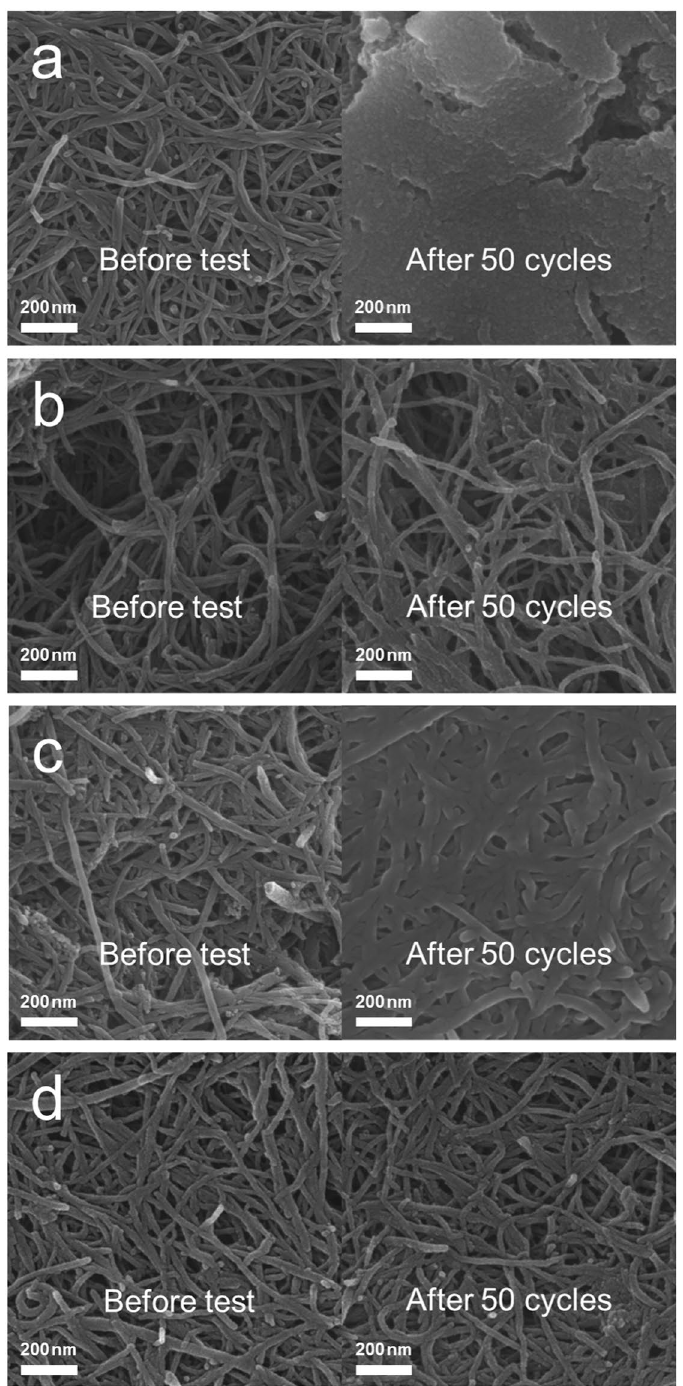
Figure 5. SEM images of the electrodes after 50 cycles (charged state). The cells were cycled at a limited capacity of 1500 mAh·g electrode − 1 . ( a ) The pristine electrode, ( b ) the PANI electrode, ( c ) the comp electrode, and ( d ) the PANI-comp